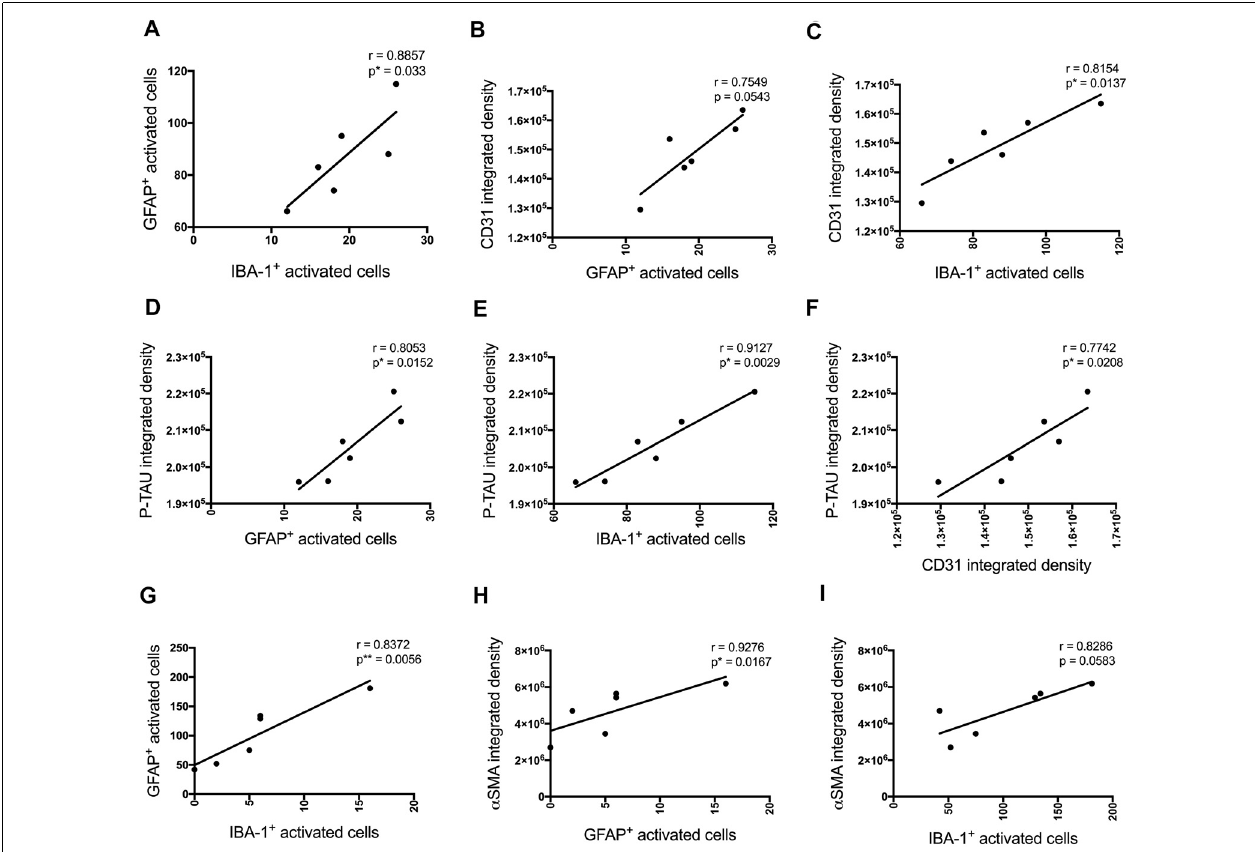
FIGURE 8 | Correlation between the number of activated astrocytes and microglia, p-tau, and vascular markers at the injection site (A–F) and at a location adjacent to the injection site (G–I) in the CA1 hippocampal region 30 days post-injection in NC, ACSF-, scrA β 1–42 - and A β 1–42 -injected mice. This relationship is represented by a Spearman’s r -value (* p < 0.05, ** p < 0.01, n =